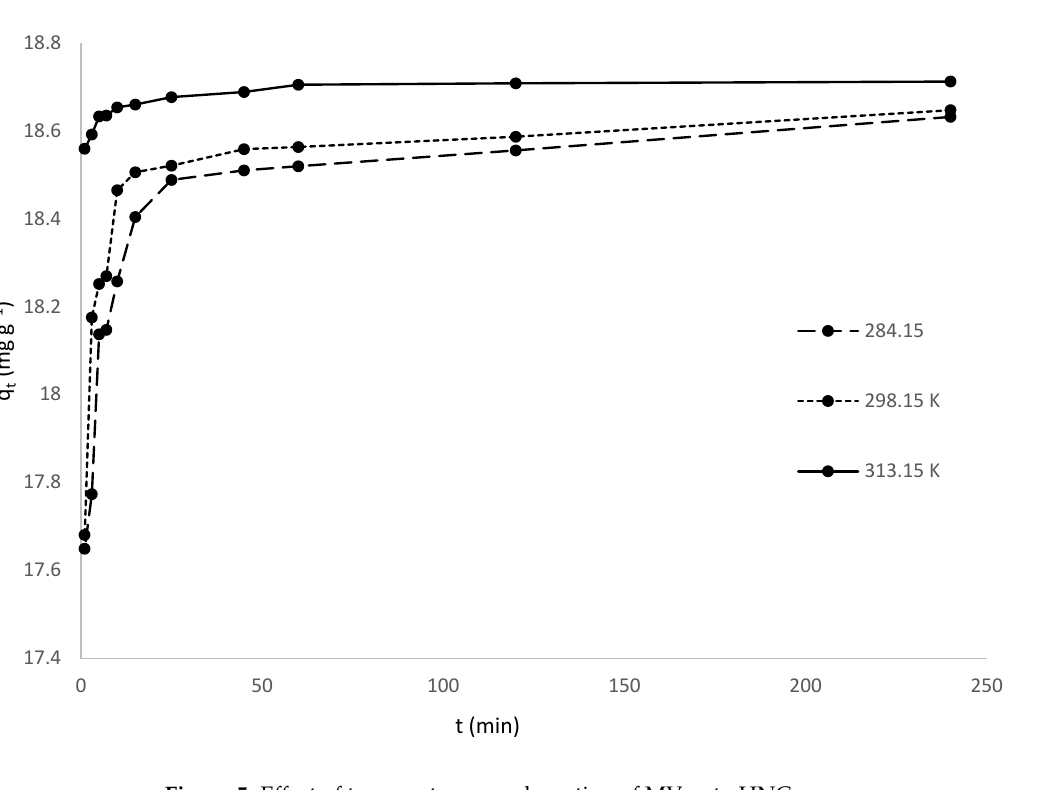
Table 2. Isotherm parameters for the adsorption of MV onto